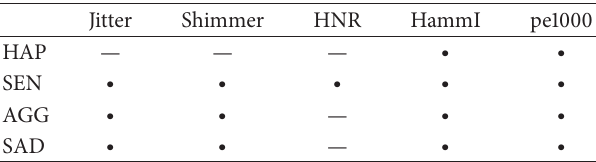
Table 3: Voice quality selected parameters during neutral-target transformations (“ ∙ ” when the parameter is selected and “—”